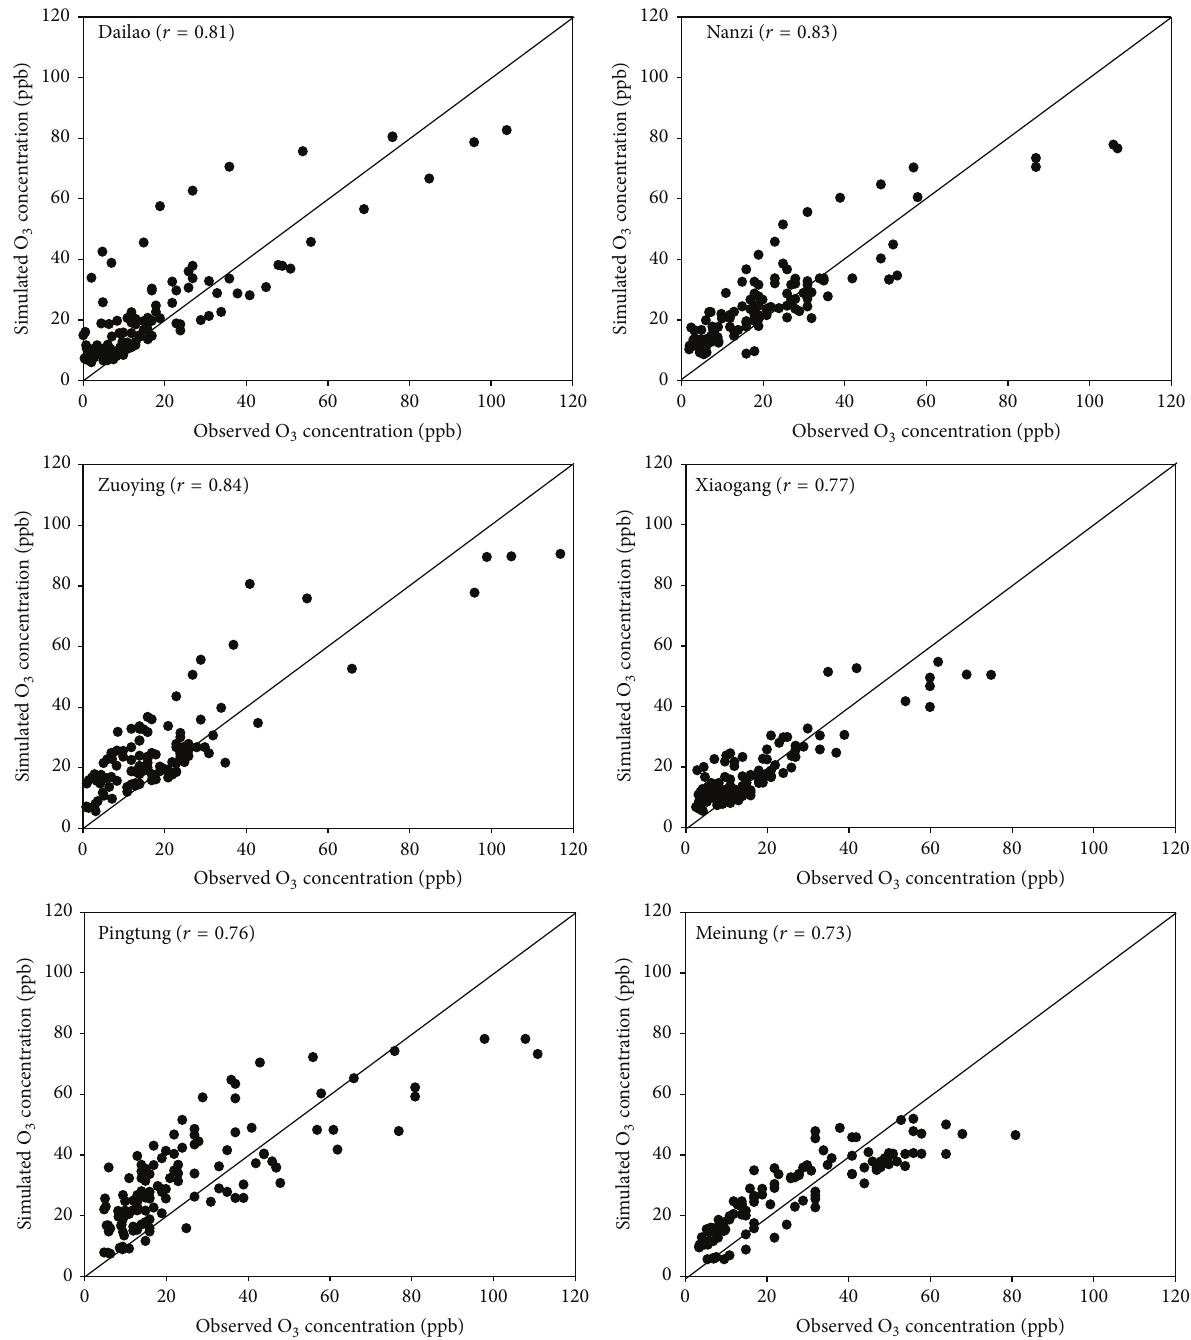
Figure 7: Relationships of simulated and observed O 3 concentration in the ambient air Southern Taiwan (from June 28 to July 2,